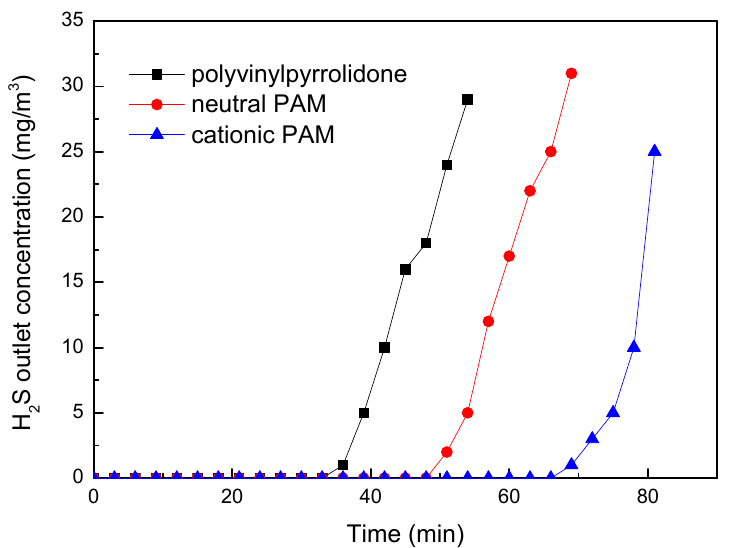
Figure 6. The breakthrough curves of hydrochar S5C5 with different auxiliary agents (T, 230 °C; auxiliary agent concentration, 2.0 g/L).